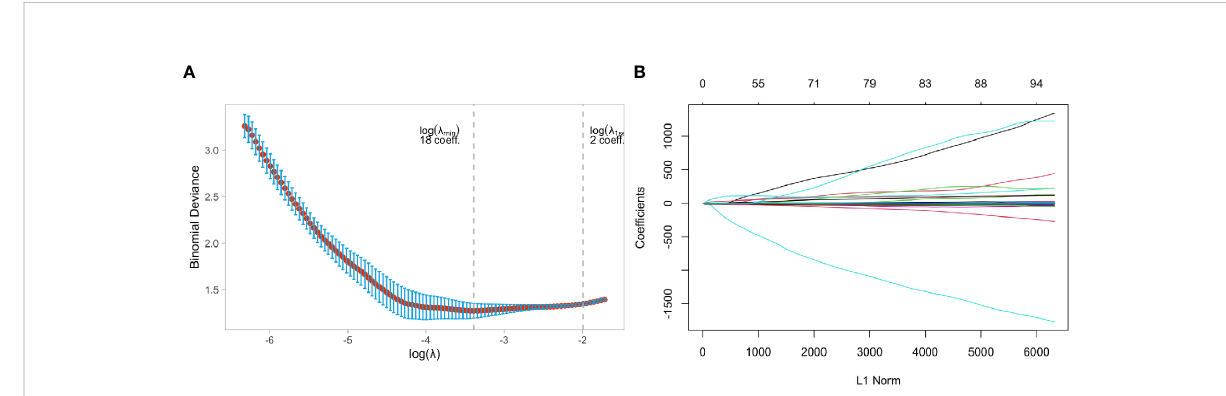
FIGURE 4 Feature selection using the least absolute shrinkage and selection operator (LASSO) binary logistic regression model in Luminal and Non-luminal group. (A) Tuning parameter selection in the LASSO model used 5-fold cross-validation via minimum criteria, (B) LASSO coef fi cient pro fi les of the baseline